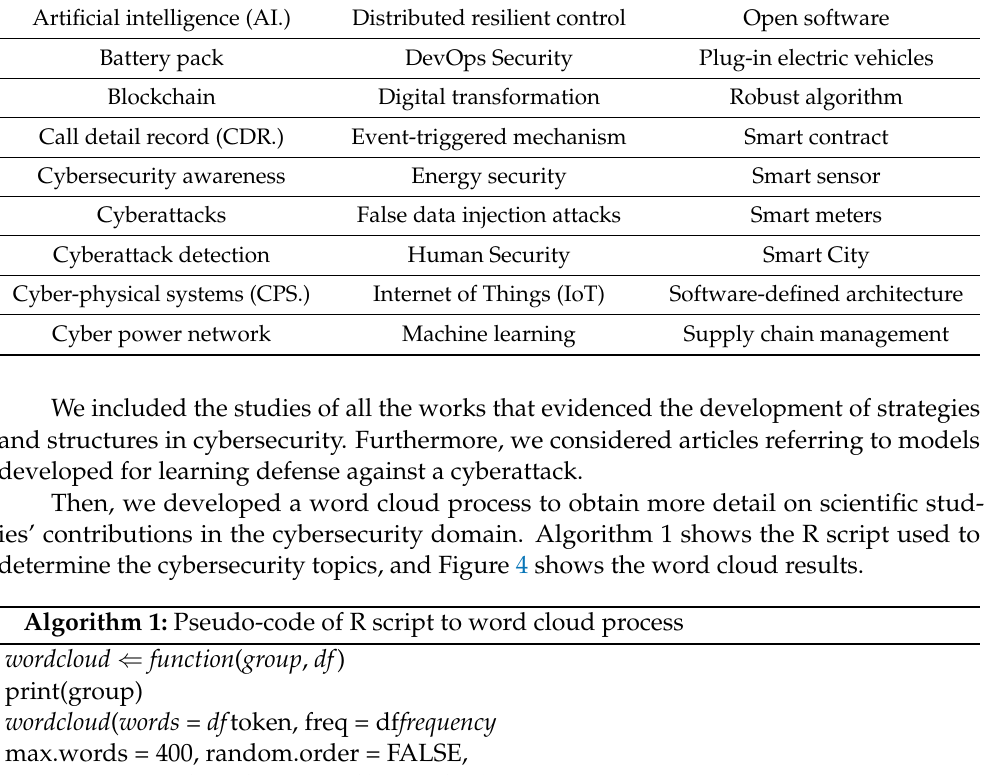
Table 2. General topics in cybersecurity between 2019 to 2021. 5G Cloud Security Microgrid AC microgrids Data integrity attack (DIA.)